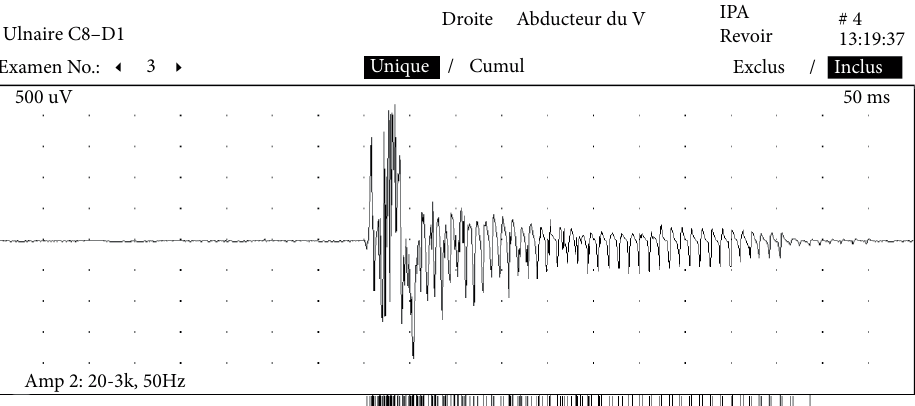
Figure 1: Electromyogram of the right 5th finger. A surface electromyogram, showing myotonic bursts in the abductor of the right 5th